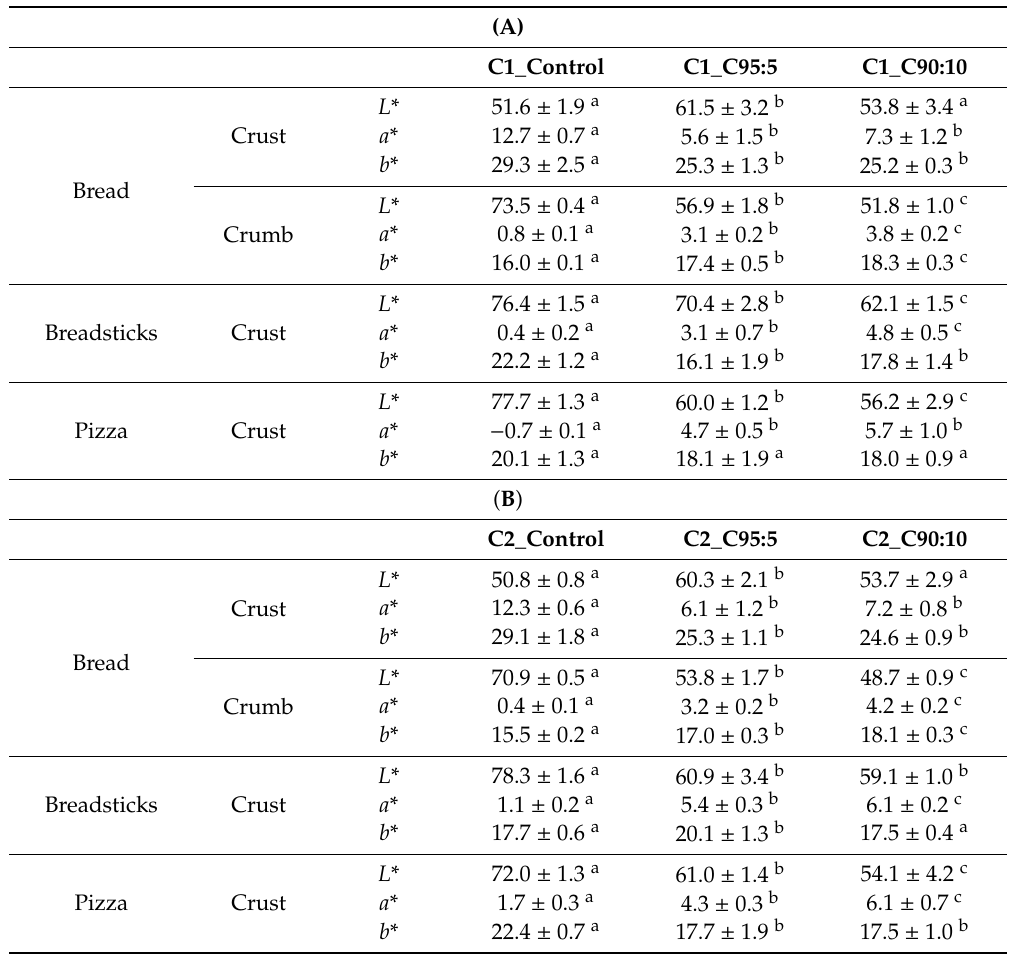
Table 3. ( A ) Crust and crumb color characteristics ( L * = luminosity; a * = redness; b * = yellowness) of bakery products with BSG addition and di ff erent types of flours for the C1 sample. ( B ) Crust and crumb color characteristics ( L * = luminosity; a * = redness; b * = yellowness) of bakery products with BSG addition and di ff erent types of flours for the C2 sample. ( C ) Crust and crumb color characteristics ( L * = luminosity; a * = redness; b * = yellowness) of bakery products with BSG addition and di ff erent types of flours for the C3